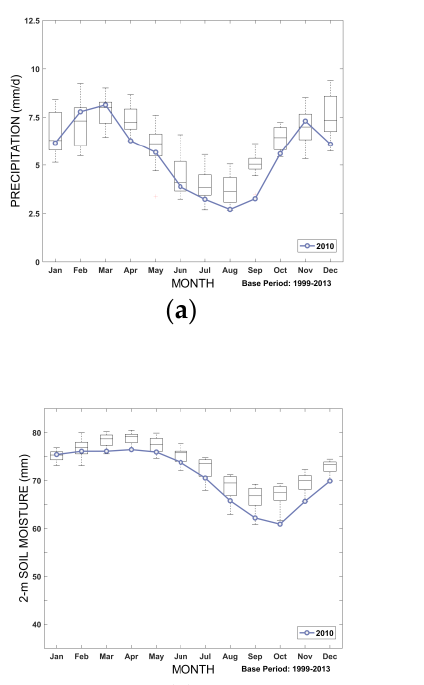
Figure 8. The same as Figure 5 but for the western region (area 2 in Figure 1) and for 2010 (blue curve).